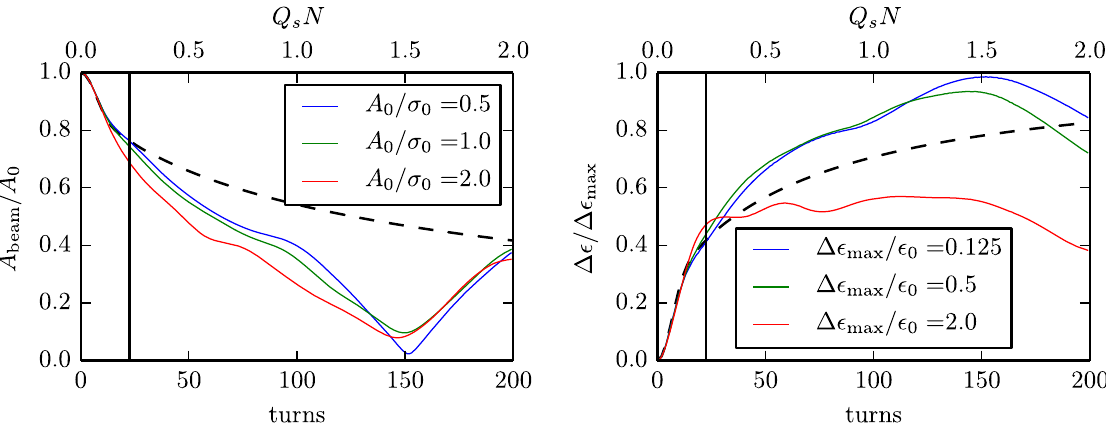
FIG. 12. Decoherence for different initial kick strength. The left-hand side plot is the time evolution of the beam oscillation amplitude. The dashed line is given by Eq. (17). The right-hand side plot is the time evolution of the emittance growth. The dashed line is calculated using Eq. (3) from the oscillation amplitude given by Eq. (17). The vertical black line is N 1 , Q 0 . 01 . parameters: q s ¼ eff ¼